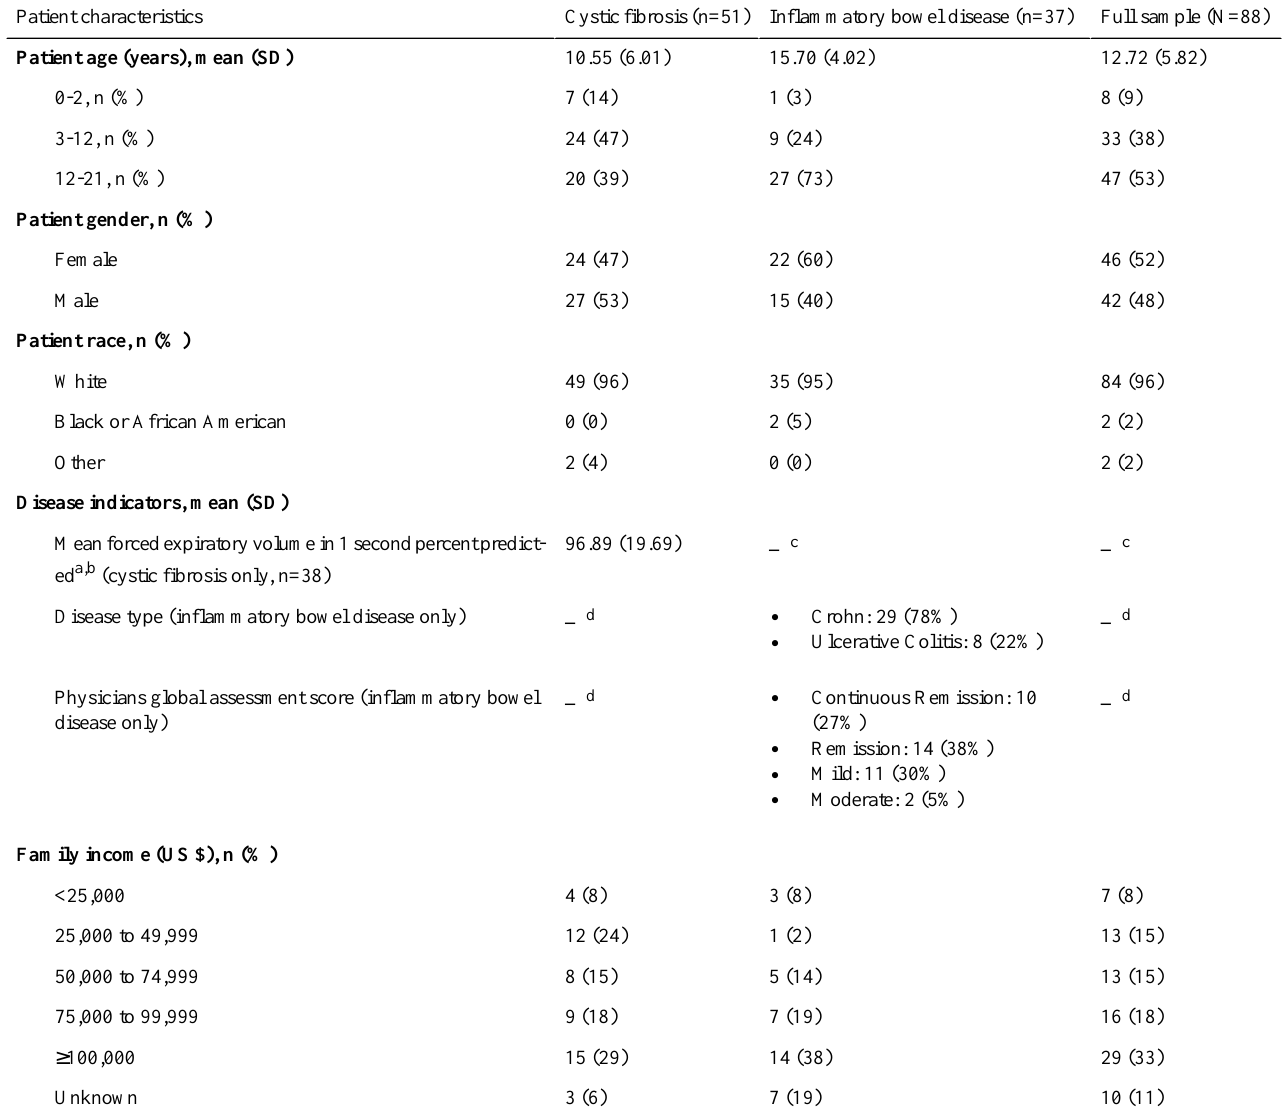
Table 1. Baseline demographic and health status characteristics of the patients for each enrolled